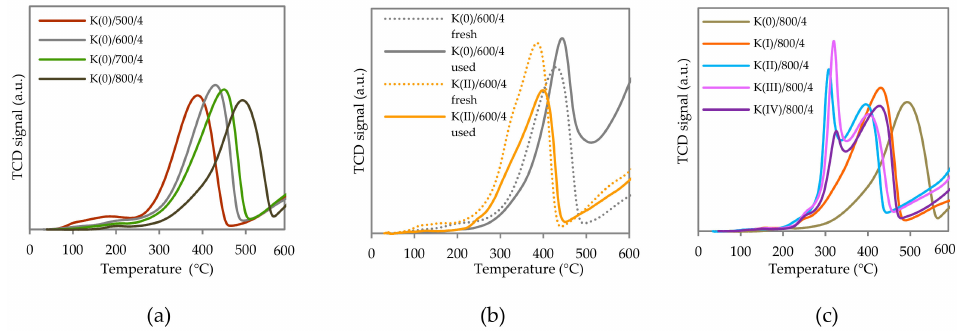
Figure 4. TPR-H 2 results of ( a ) non-promoted samples calcined at 500–800 ◦ C, ( b ) fresh (dashed lines) and used potassium non-promoted and promoted samples calcined at 600 ◦ C and ( c ) fresh samples calcined at 800 ◦ C containing di ff erent amount of